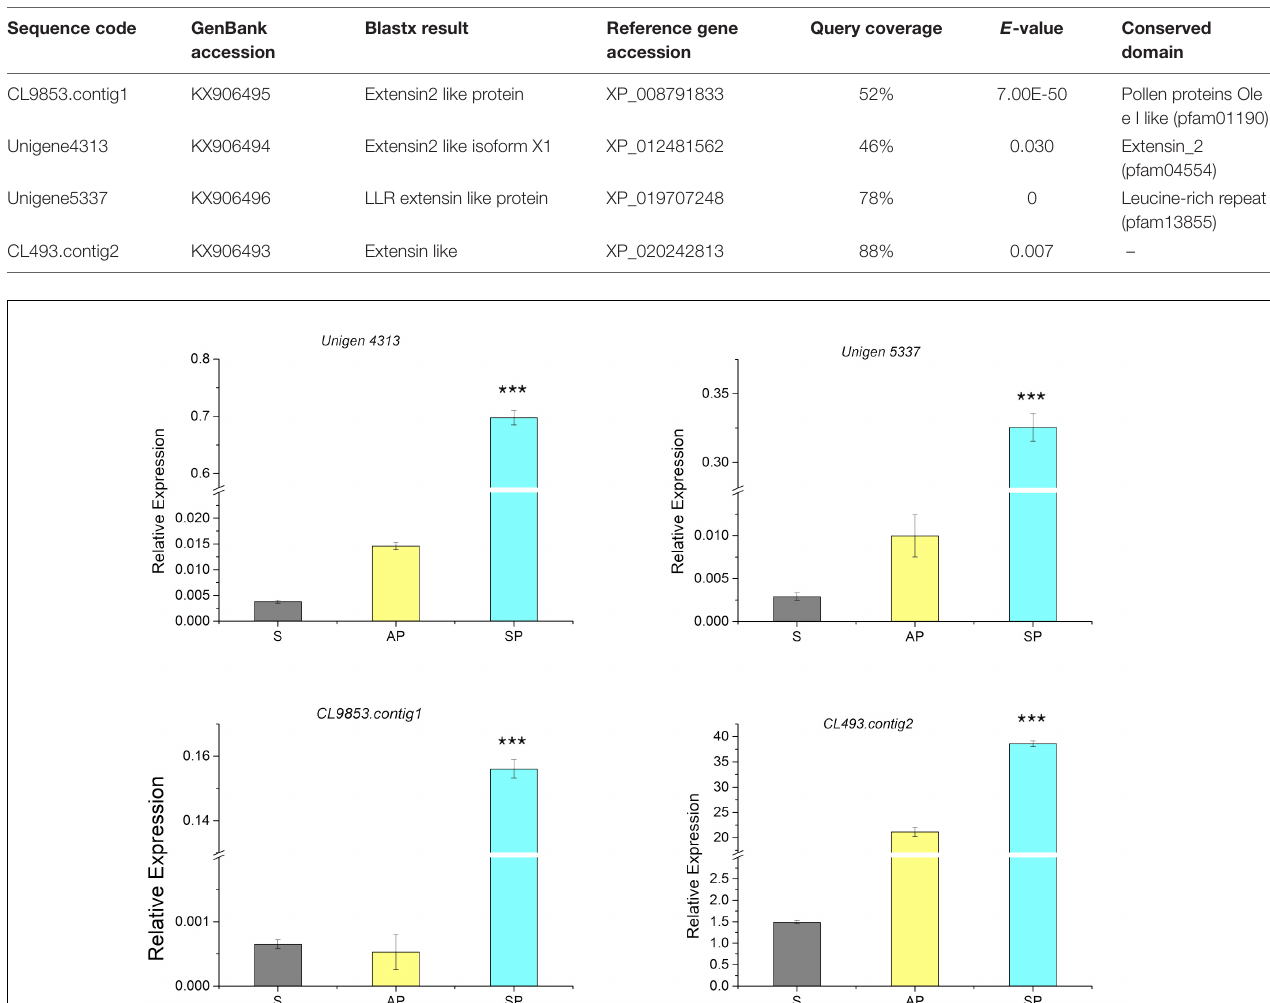
TABLE 1 | D. officinale extensin-like genes investigated by real-time PCR.